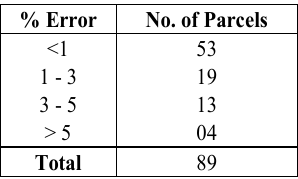
Table 4. Comparison between Old RoR Records and